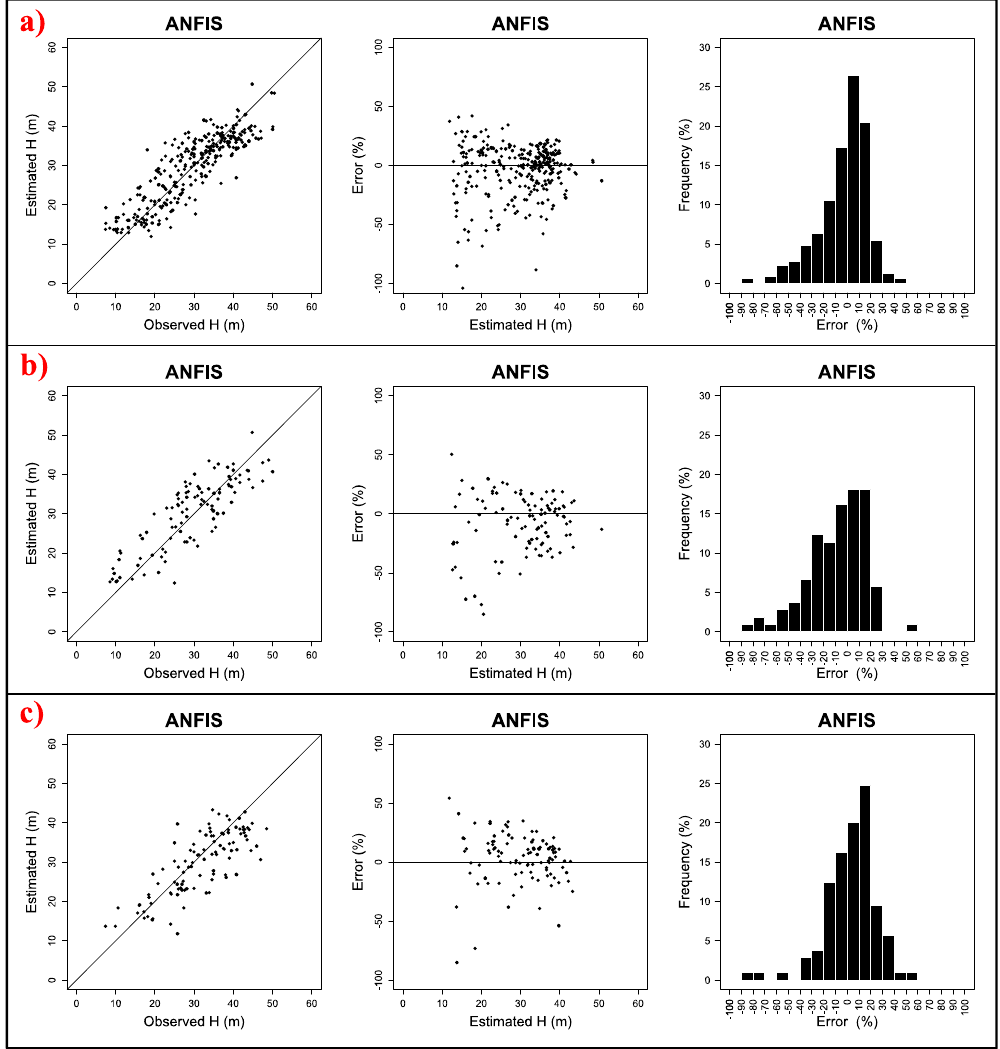
Figure 8. Estimated heights versus observed heights, distributions of percentage errors of height estimates, and histograms of errors of height estimates, obtained by ANFIS, for training ( a ), validation ( b ), and test ( c ) data.